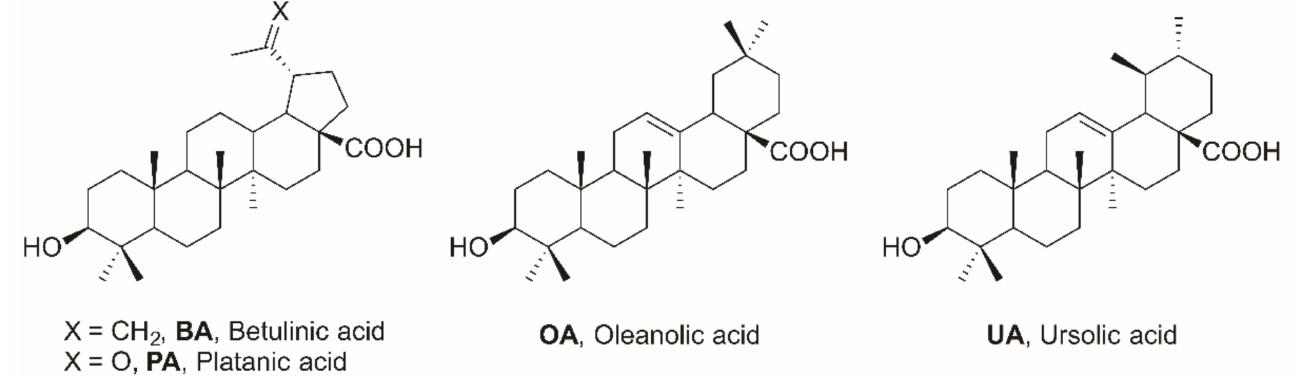
Figure 1. Structure of betulinic acid ( BA ), platanic acid ( PA ), oleanolic acid ( OA ), and UA (ursolic